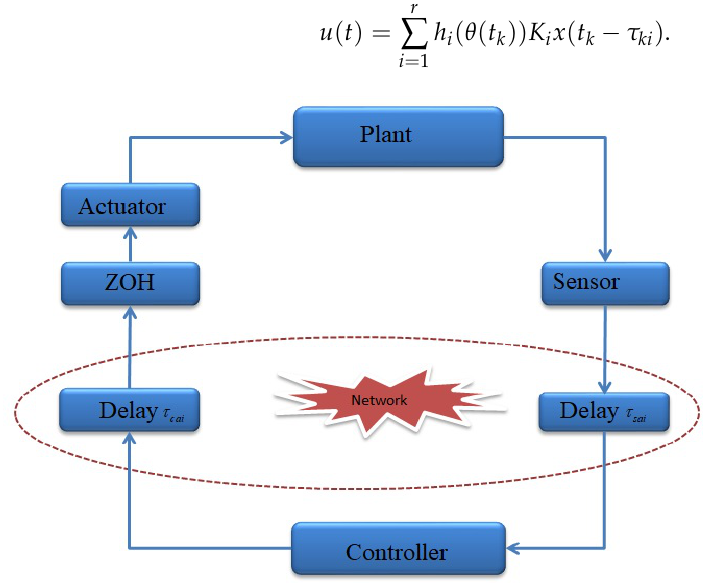
Figure 1. Schematic diagram for fractional order networked control